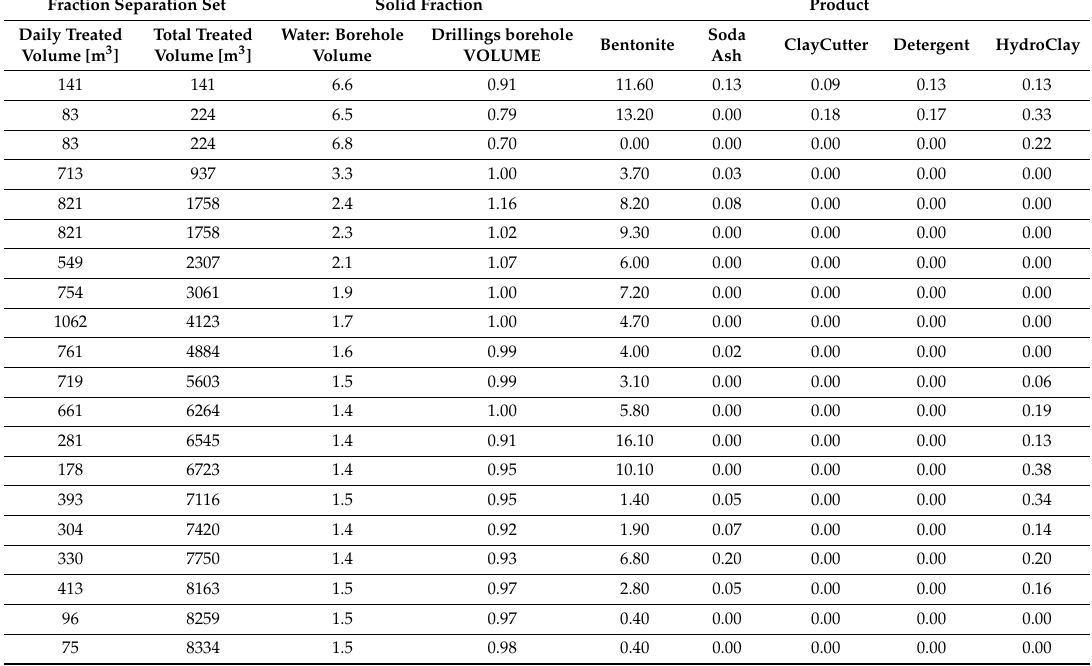
Table 5. Volume of drilling fluid, treated per day, and the basic data from the solid fraction and applied additives in the P˛ecisz ó w facility.